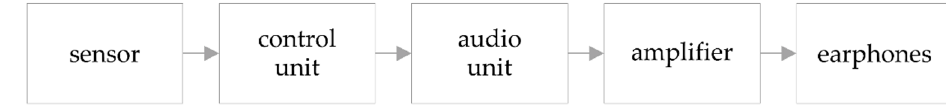
Figure A1. Sound reproduction unit. Table A1. Overview of intensity perception of tactile impulses determined in this study (%). Figure